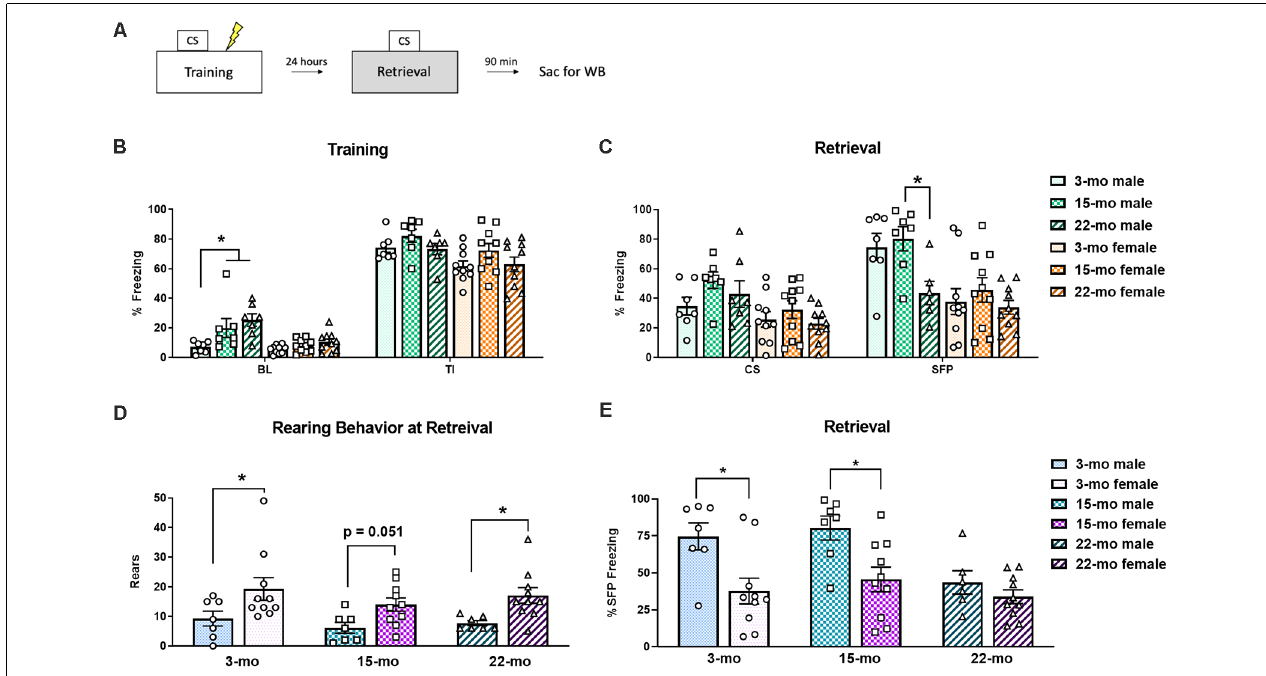
FIGURE 1 | Subjects were trained in trace fear conditioning (TFC) and tested for memory retention 24 h later. (A) A schematic of the experimental design. (B) During training, both 22 month (mo) and 15-mo males showed more freezing behavior than 3-mo males at baseline (BL). However, all animals reacted normally to shock, as seen by increased freezing during the trace intervals (TI). (C) During retrieval testing, while no effects of age were noted during the conditioned stimulus (CS) period, during stimulus free period (SFP) 22-mo old males displayed a deficit in memory retention. No effect of age was noted in females. (D) To better understand the behavioral topography of fear responses, rearing behavior was also analyzed during the retrieval test. Overall, females engaged in more rears than males did. (E) We also performed planned comparisons across sex within each age group during retrieval testing. At the SFP period, 3- and 15-mo males froze more than their female counterparts, while 22-mo old males did not. Data are shown as mean ± standard error of the mean (SEM). *Indicates P <